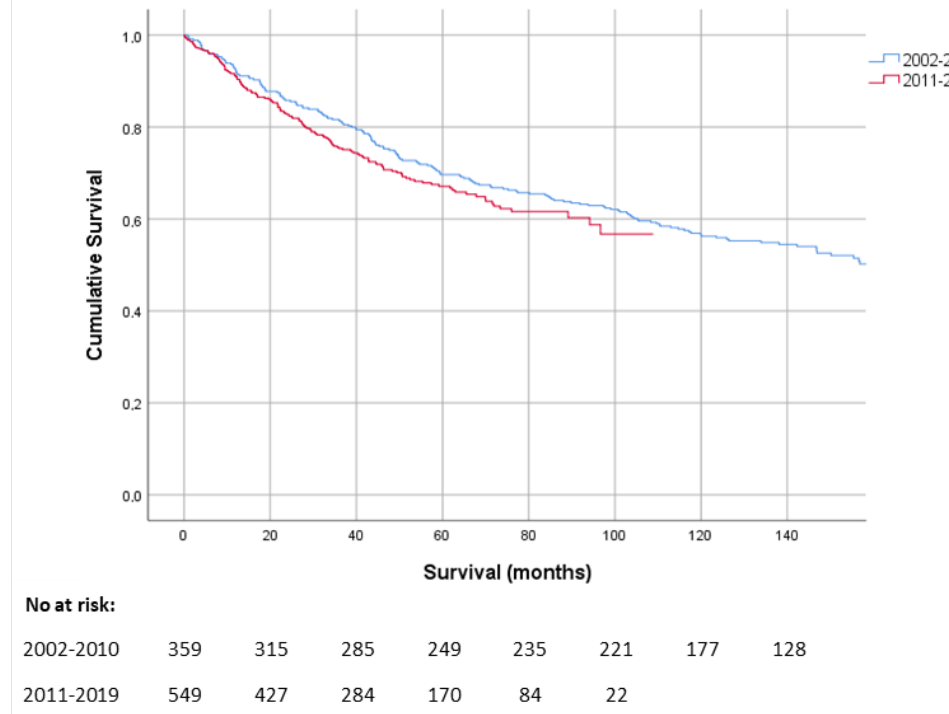
Figure 1. Kaplan–Meier curve showing the survival of MFS patients diagnosed in 2002–2010 in Figure 1. Kaplan – Meier curve showing the survival of MFS patients diagnosed in 2002 – 2010 in comparison to patients that were diagnosed in comparison to patients that were diagnosed in 2011 – 2019.